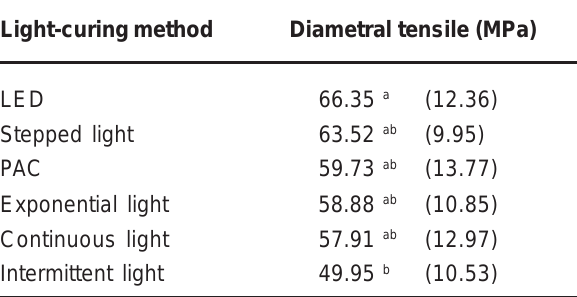
TABLE 3- Means of diametral tensile strength of Z250 composite